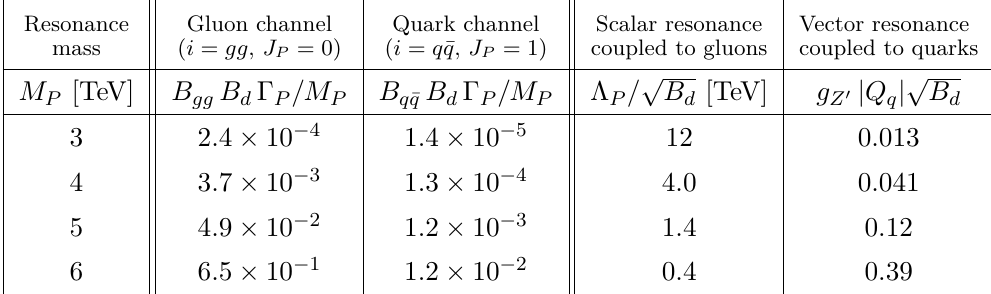
√ B d |√ B d (for the model with vector